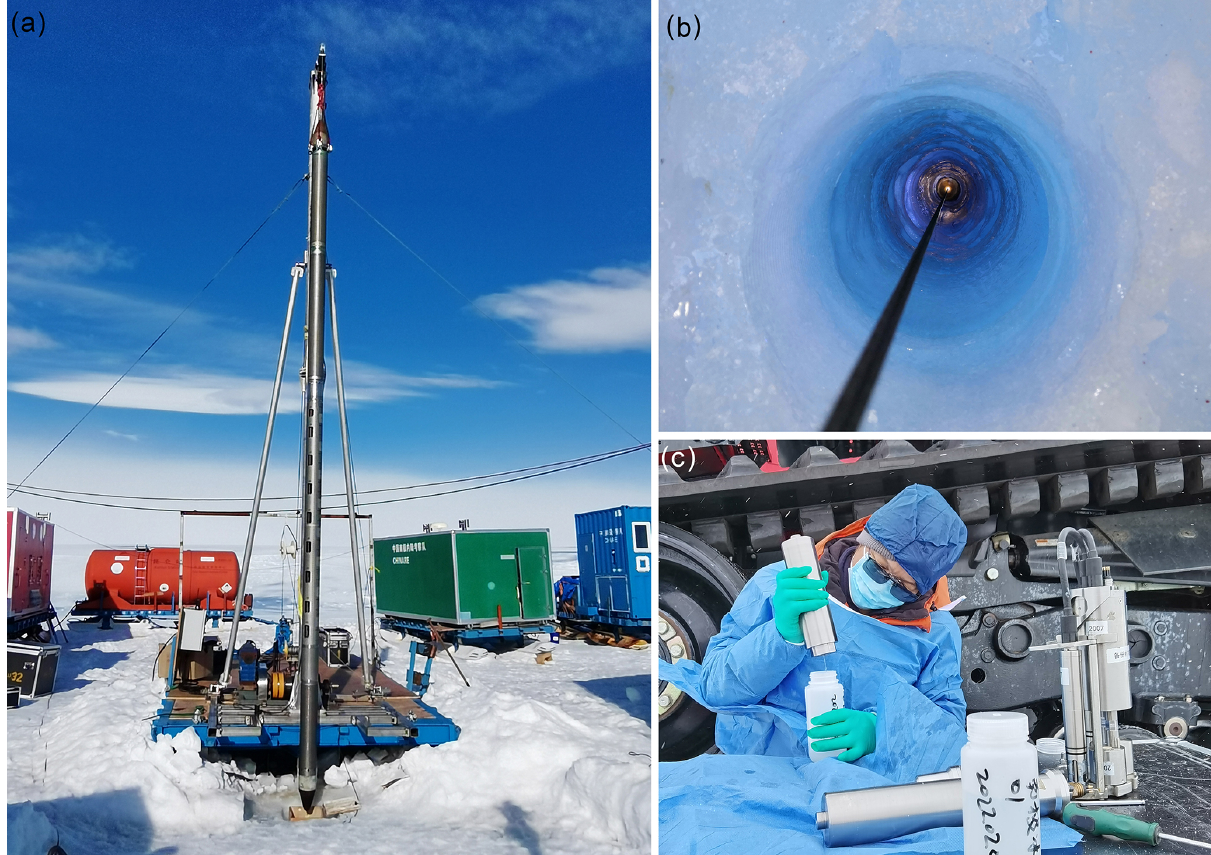
Figure 3. RECAS field tests in Antarctica near the Chinese Zhongshan Station, January 2022. (a) The RECAS sonde (in the foreground) is ready for deployment. (b) Sonde on the way to the base of the ice sheet: because of the surface crevassing, meltwater drained from the borehole and down to the depth of approximately 11m remained dry. (c) Sample of basal ice water is poured from sterile pressurized